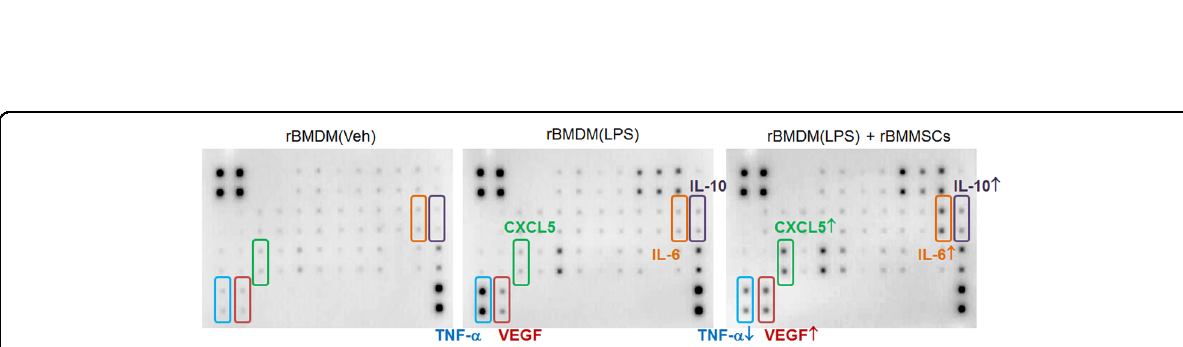
Fig. 2 Antibody array showing that the soluble mediator pro fi les from BMDMs are altered by coculture with BMMSCs. rBMDM (Veh) Vehicle- treated rat BMDMs; rBMDM (LPS) LPS-stimulated rat BMDMs; rBMDM (LPS) + rBMMSCs, LPS stimulation of rBMDMs followed by coculture with rBMMSCs